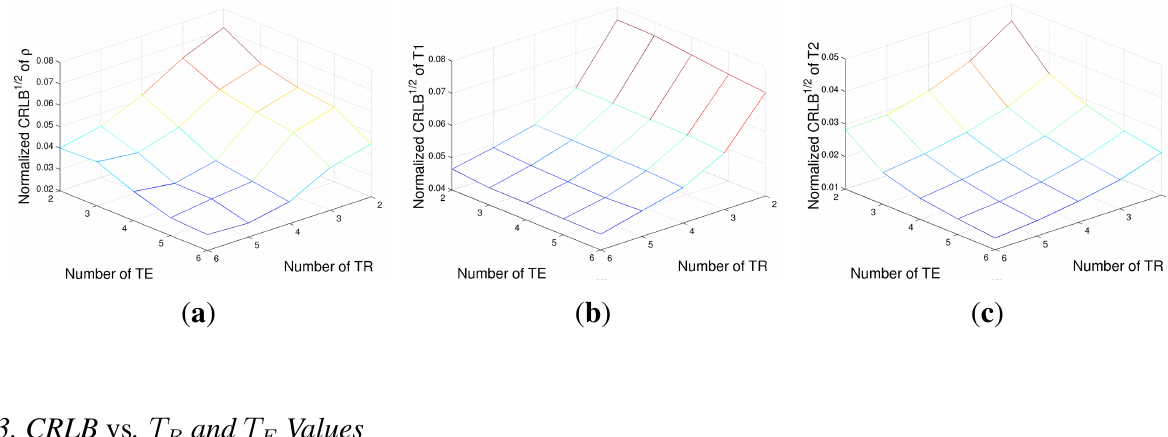
Figure 2. The square root of the CRLB of proton density ρ ( a ), T T relaxation time ( c ) for different numbers of 2